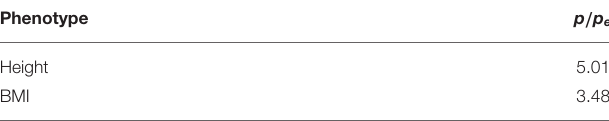
TABLE 4 | Effective number of